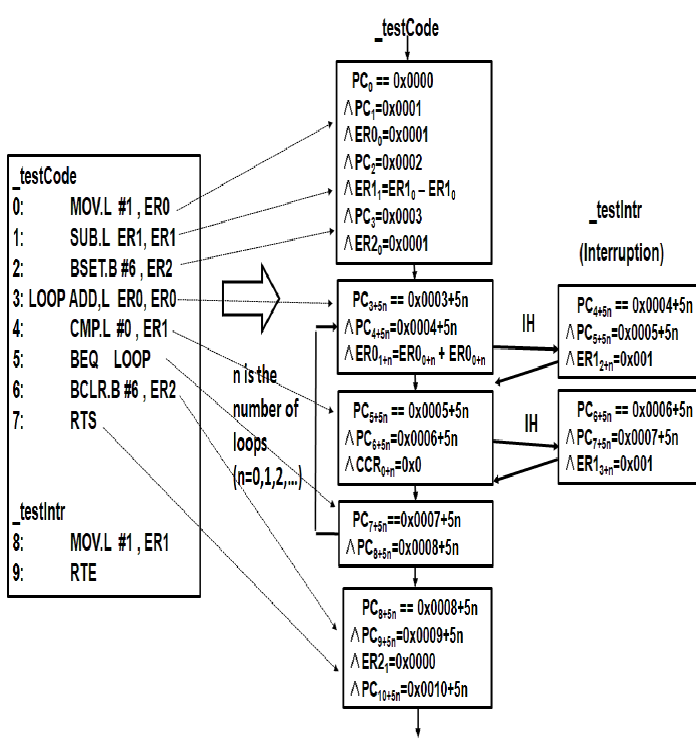
Figure 8. CFG of